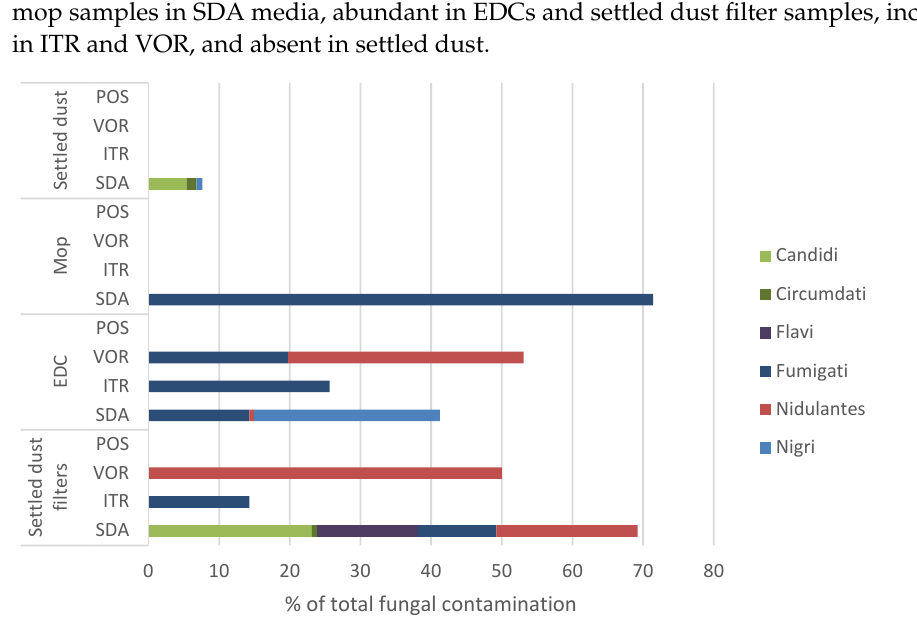
Figure 5. Relative distribution of Aspergillus sections per matrix type in SDA and azole-supplemented SDA media (ITR, VOR, POS) regarding total fungal contamination. SDA (Sabouraud Dextrose Agar); ITR (Itraconazole); VOR (Voriconazole); POS (Posaconazole); EDC (Electrostatic dust